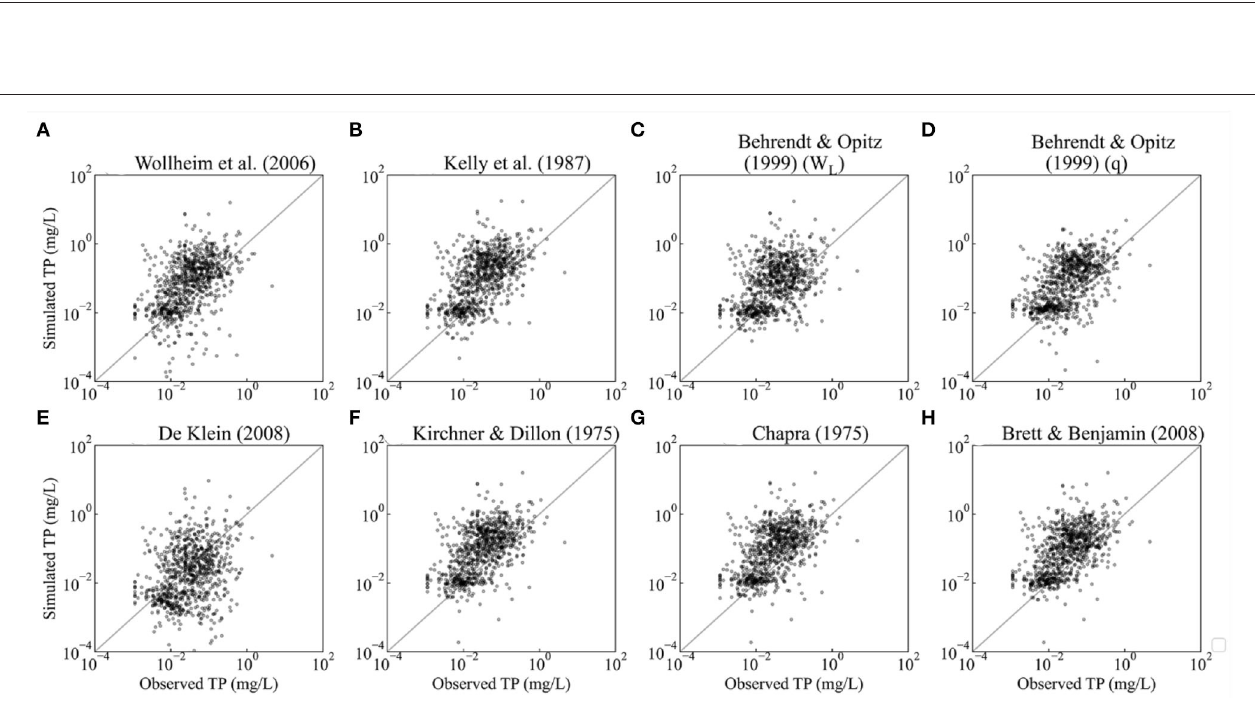
FIGURE 2 | Validation of predicted values against observations of annual average concentration for riverine N (each dot represents the predicted values against average observed N concentration of the measurement stations within the same cell). The sample size is 449, the number of grid cells covered by measurement stations. (A–G) indicate the plots of different retention models.